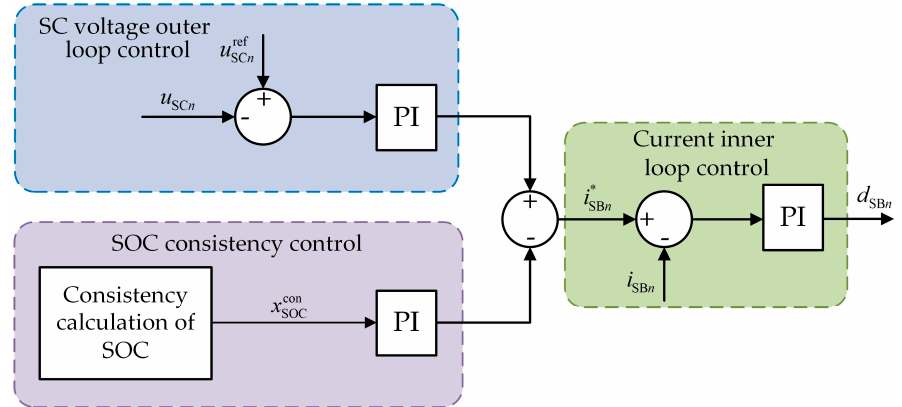
Figure 13. Control scheme of the ESB controller for bidirectional DC–DC converter 2.